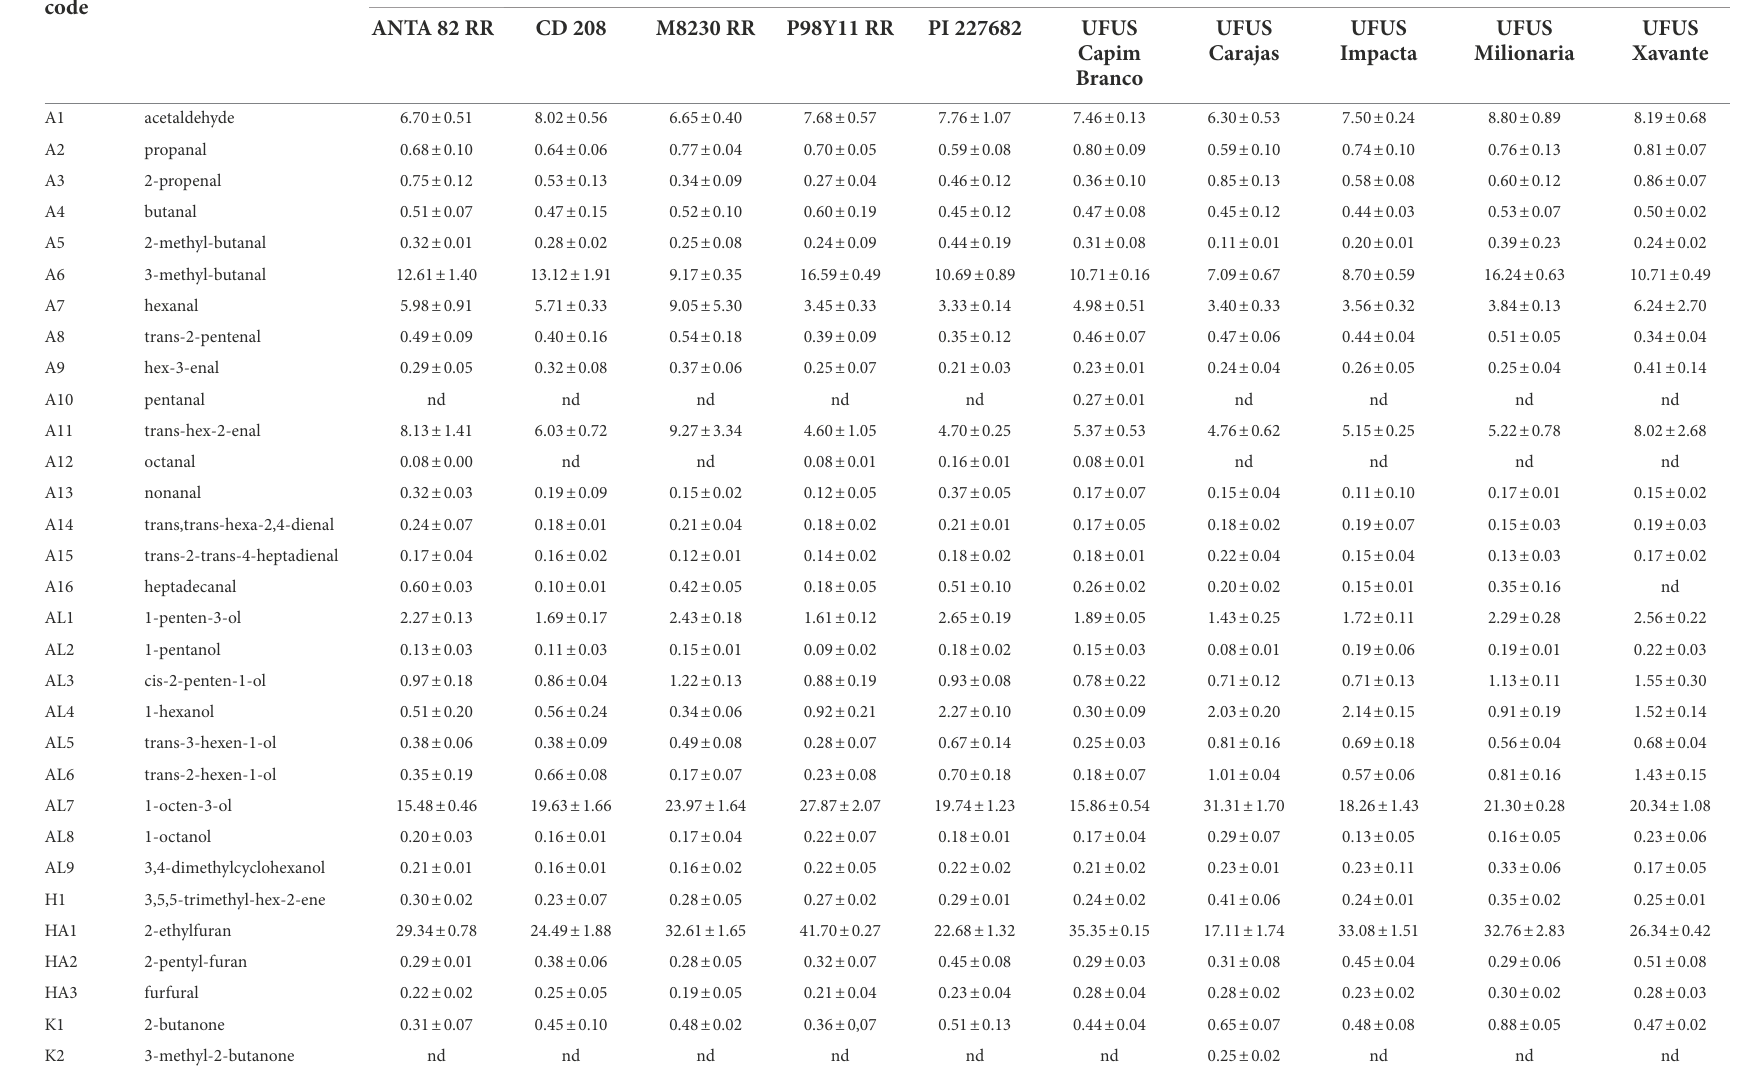
TABLE 3 Volatile compoundrelative areas from Glycine max leaf extract from 10